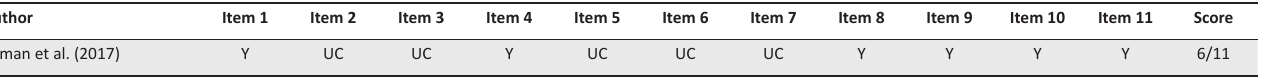
TABLE 1: Evidence grading scores according to Physiotherapy Evidence Database criteria.